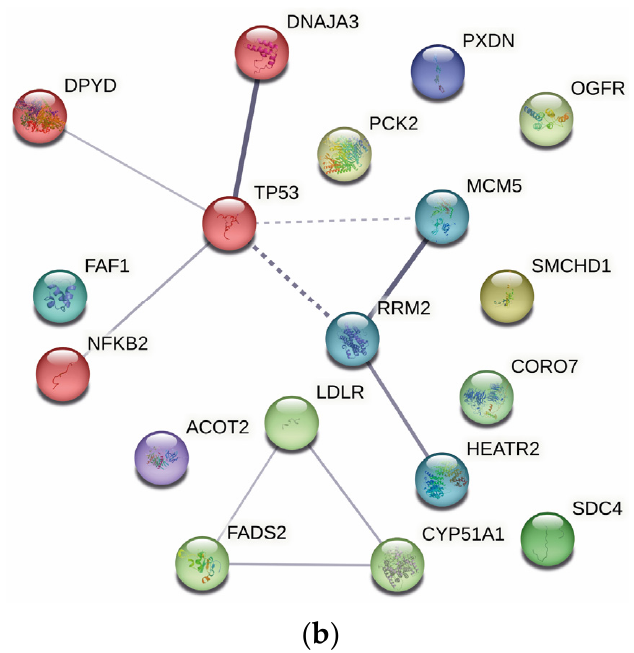
Figure 6. Interaction network for shared proteins between CuHL1 and CuHL2. ( a ) Up-regulated proteins; ( b ) Down-regulated proteins. Generated using the STRING v11.5 database. The thickness of the line indicates the degree of confidence of the interaction. A variety of interaction sources were included into the search strategy, such as text mining, experiment record, database record, coexpression, neighborhood, gene fusion, and co-occurrence.